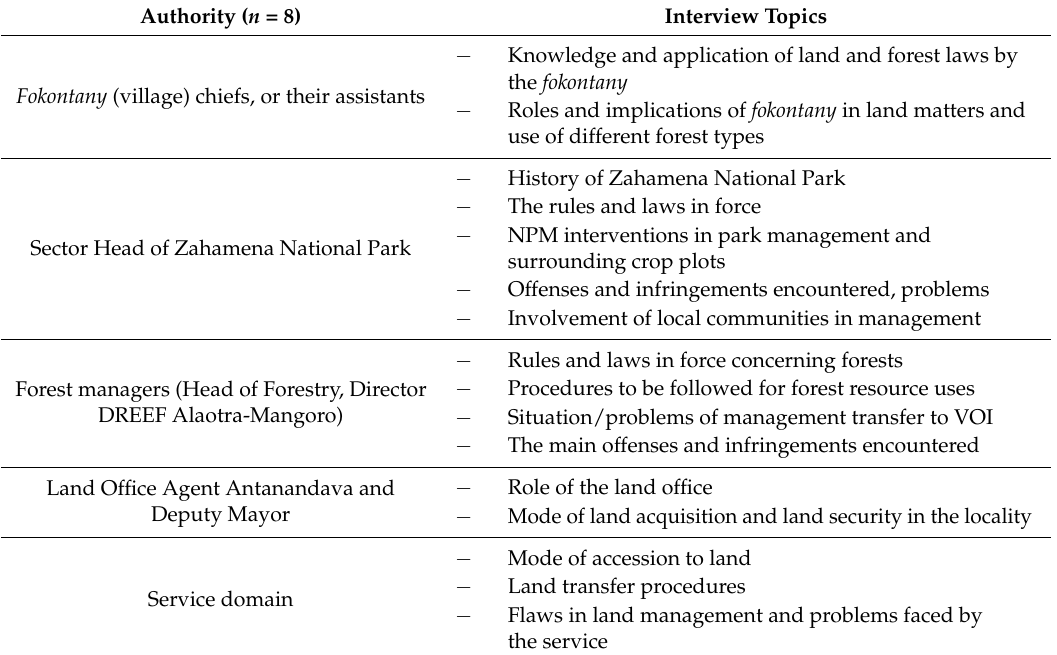
Table A2. Details on the interviews with regional and local